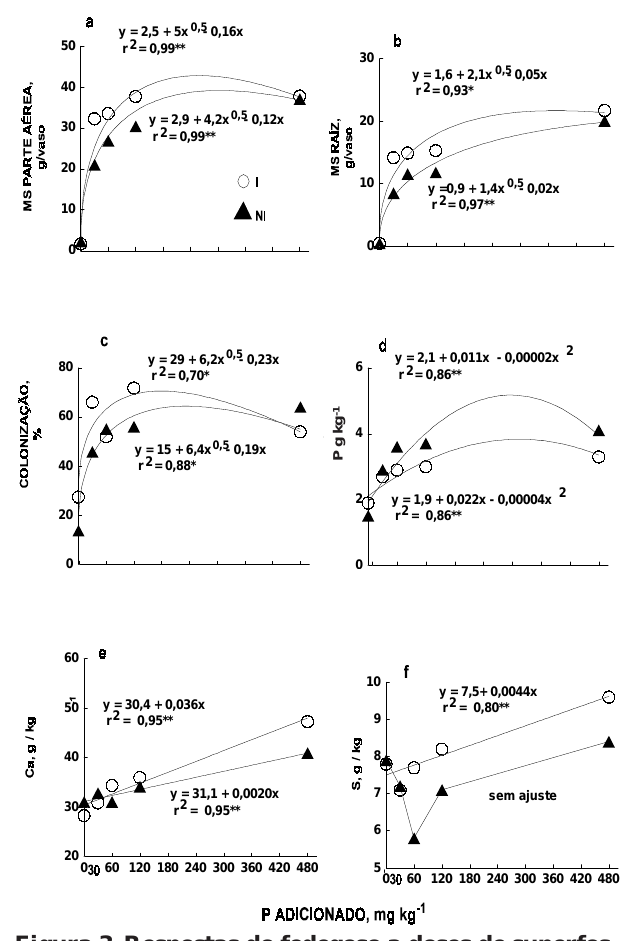
Figura 3. Respostas do fedegoso a doses de superfos- fato e à inoculação com o fungo micorrízico G. etunicatum (I - inoculado; NI - não inoculado) em latossolo vermelho-escuro de baixa fertilidade